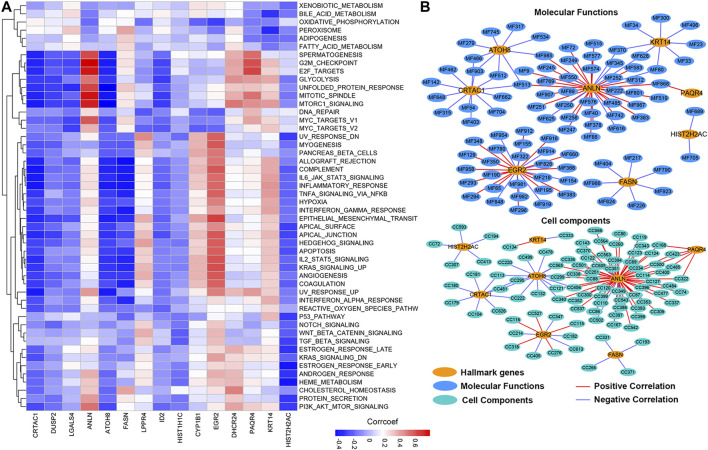
The potential cancer hallmark pathways, molecular functions, and cell components associated with prognosis-related genes. (A) The heatmap shows the positive or negative correlations between hallmark-related cancer pathways and genes. Positive correlations are shown by red; negative correlations are shown by blue. (B) The PPI network diagram shows the cell components and molecular functions that have potentially regulation by the prognosis-related genes.